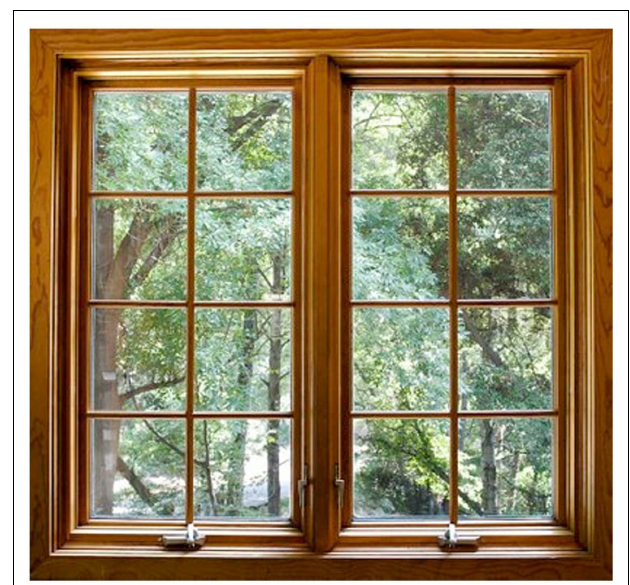
FIGURE 5 | Physical and psychological health and natural